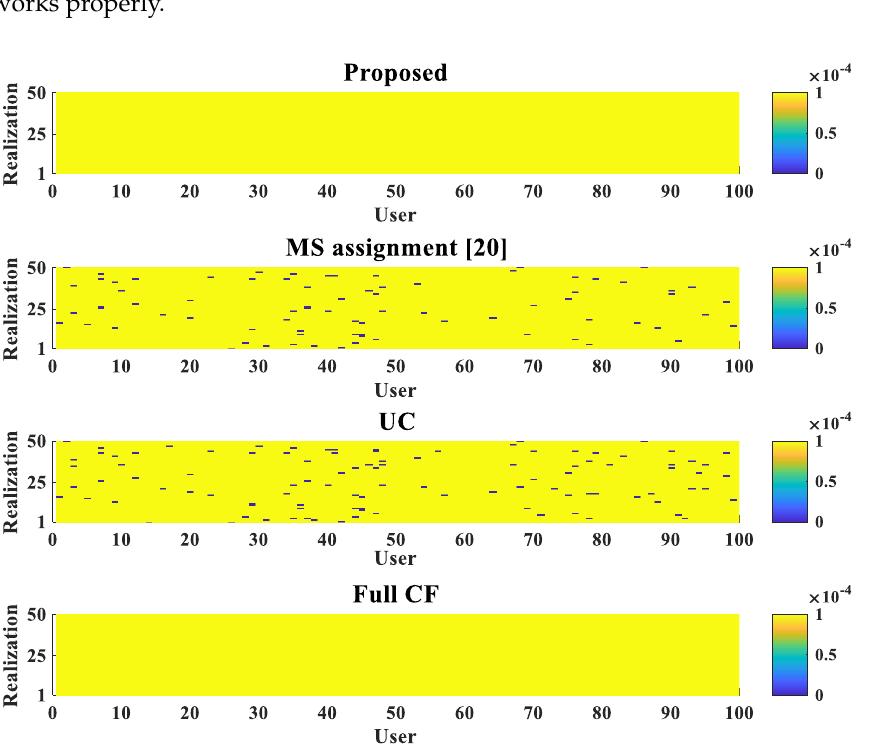
Figure 4. Realization of unserved-user for four